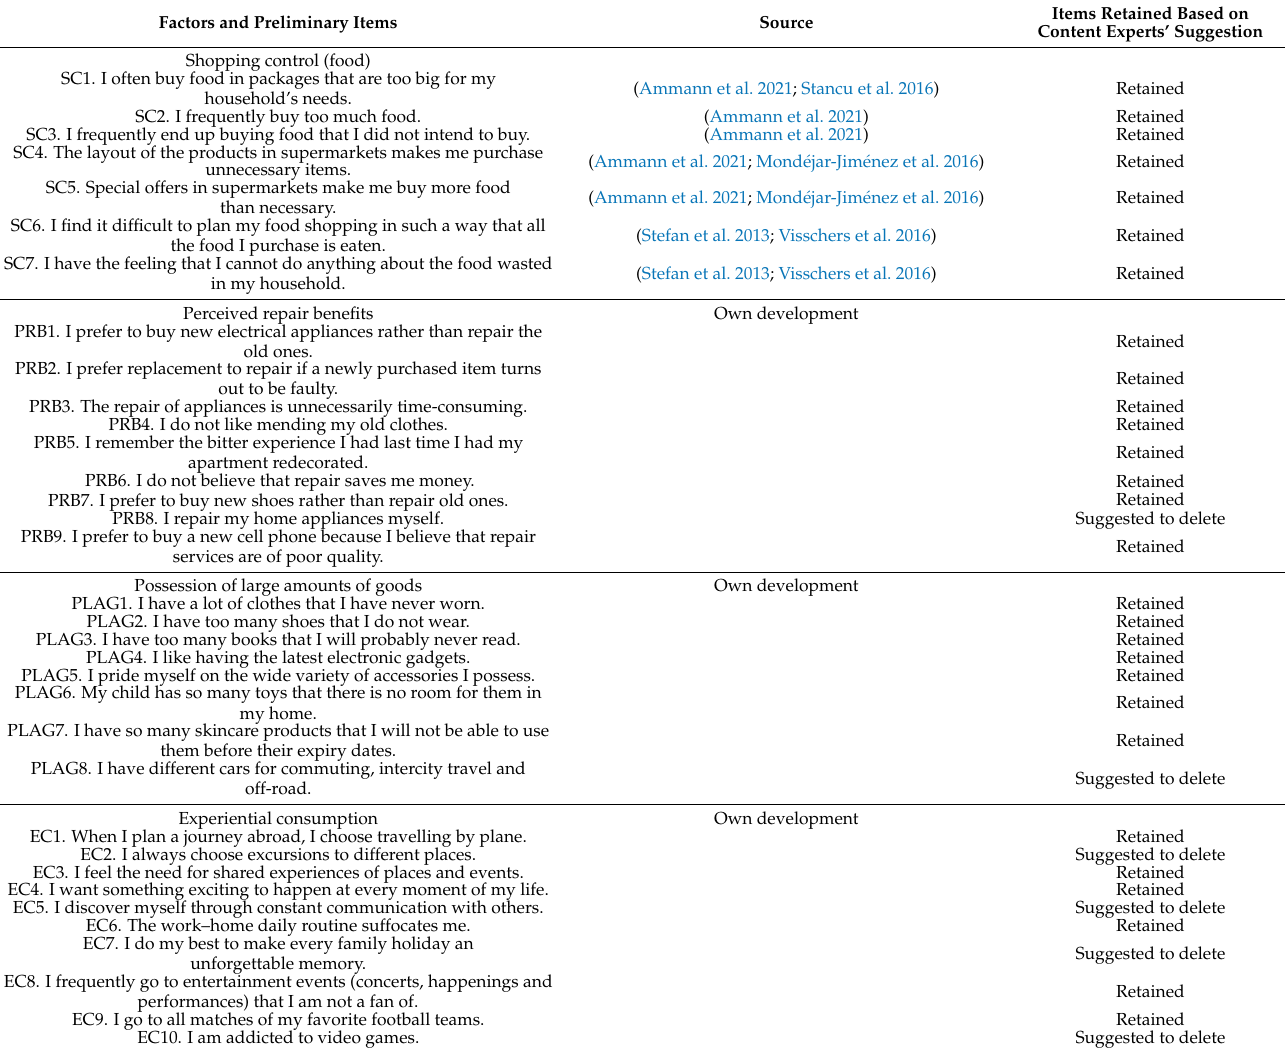
Table A1. Items generated from the qualitative study and purified based on content